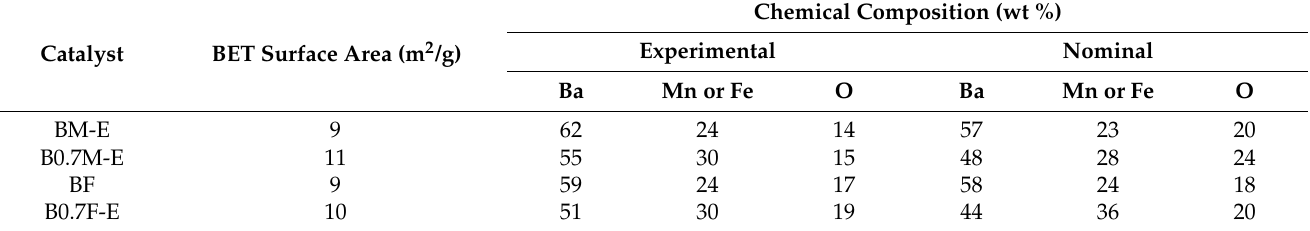
Table 2. Chemical bulk composition and specific surface area data for BM-E, B0.7M-E, BF, and B0.7F-E